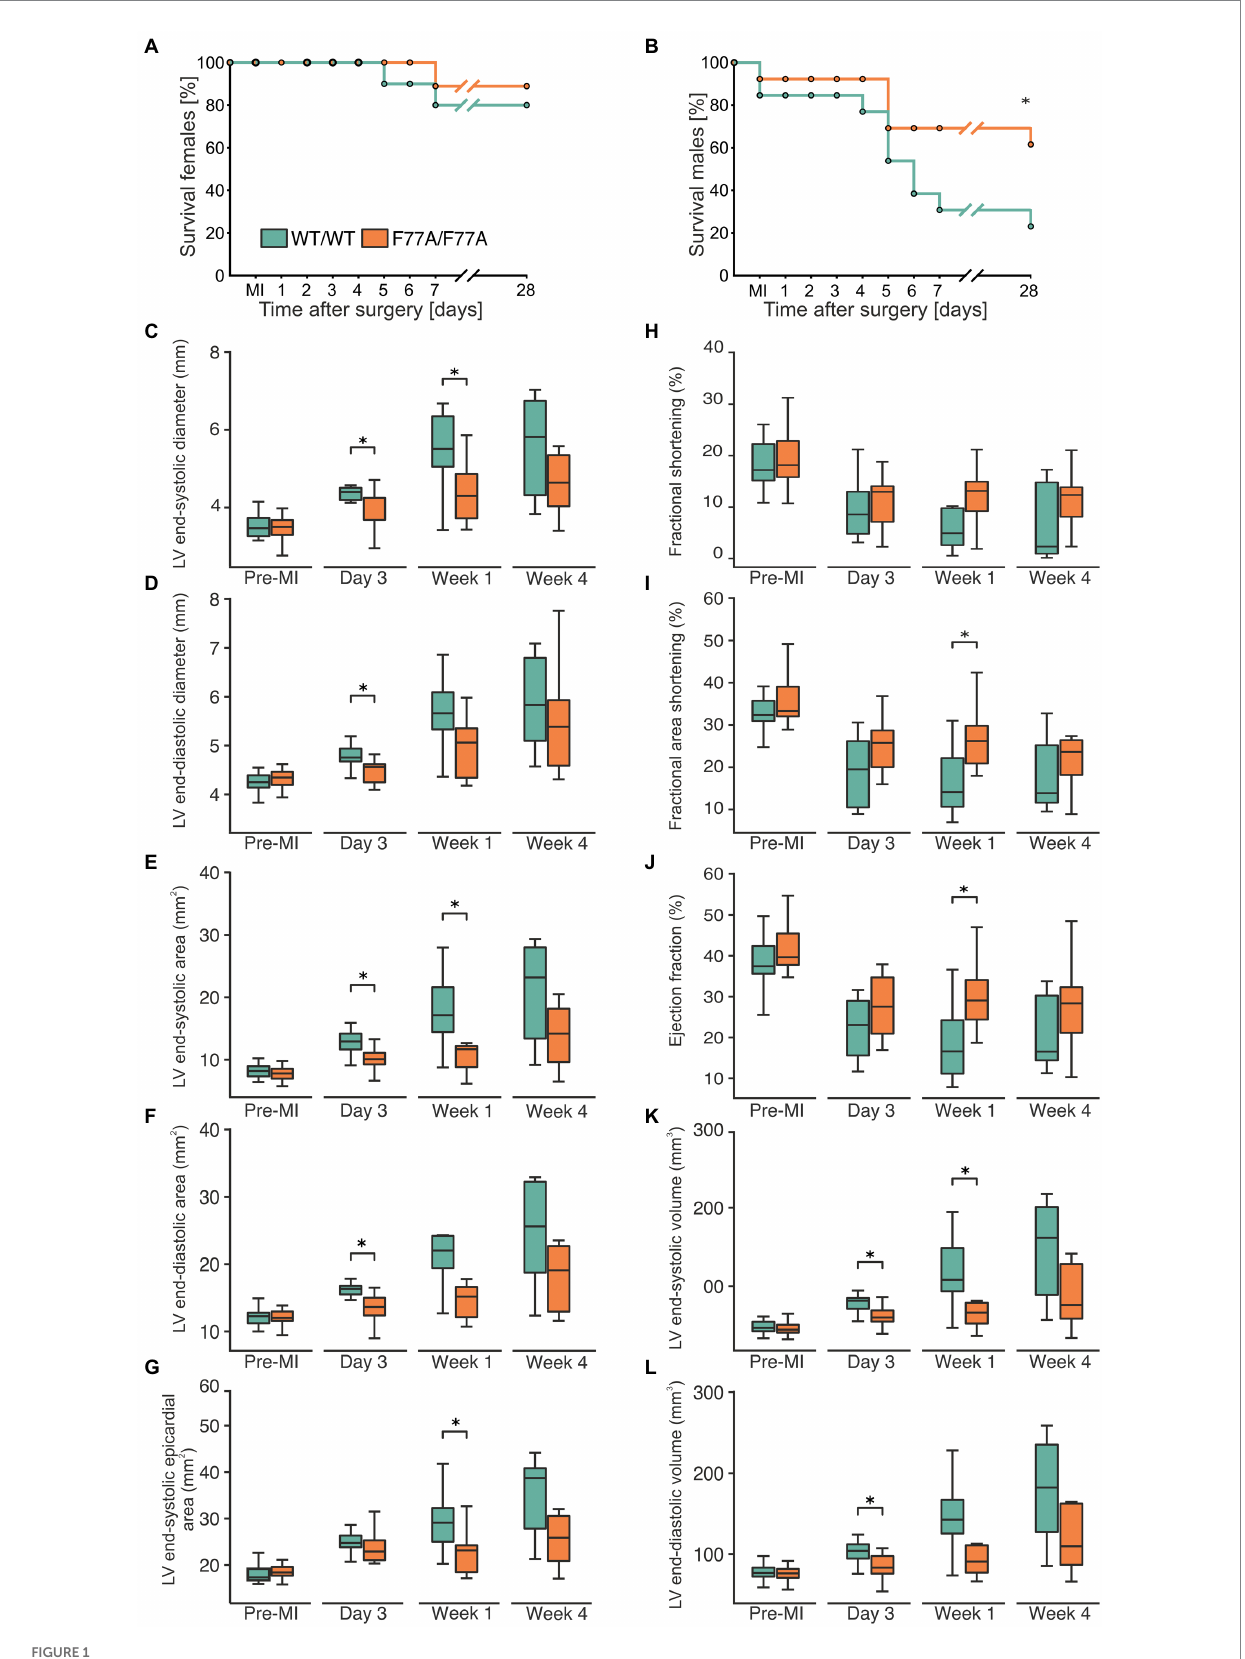
FIGURE 1 The STAT1-F77A mutation protects mice from adverse remodelling after myocardial infarction. (A,B) Kaplan-Meier curves showing the survival rates of female (A) and male (B) mice expressing homozygously either STAT1 WT (green) or the amino-terminal F77A mutation (orange) after